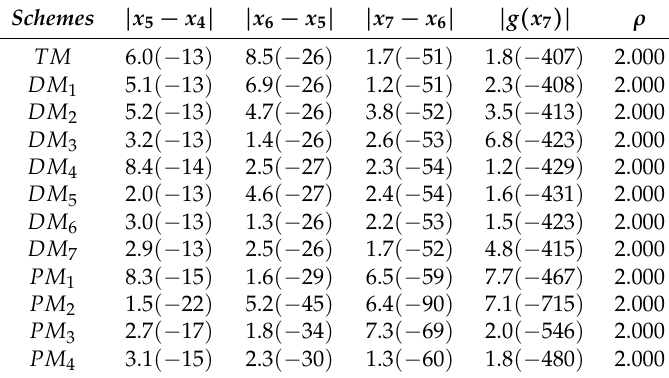
Table 4. Numerical results of Example 3.